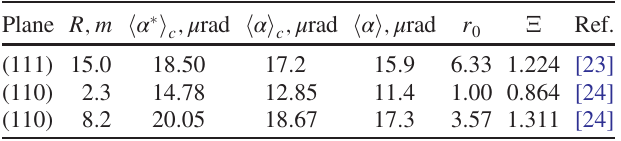
TABLE III. Experimental data for the mean volume reflection angle in bent germanium crystals. Here h α (cid:4) i c ; h α i c and h α i are the calculated (for Moliere and Hartree-Fock approximations, cor- respondingly) and measured values of the volume reflection angle at E 0 ¼ 400 GeV. r 0 ¼ R=R 0 and Ξ ¼ h α i = θ c , where θ c corre- sponds to Hartree-Fock calculations.